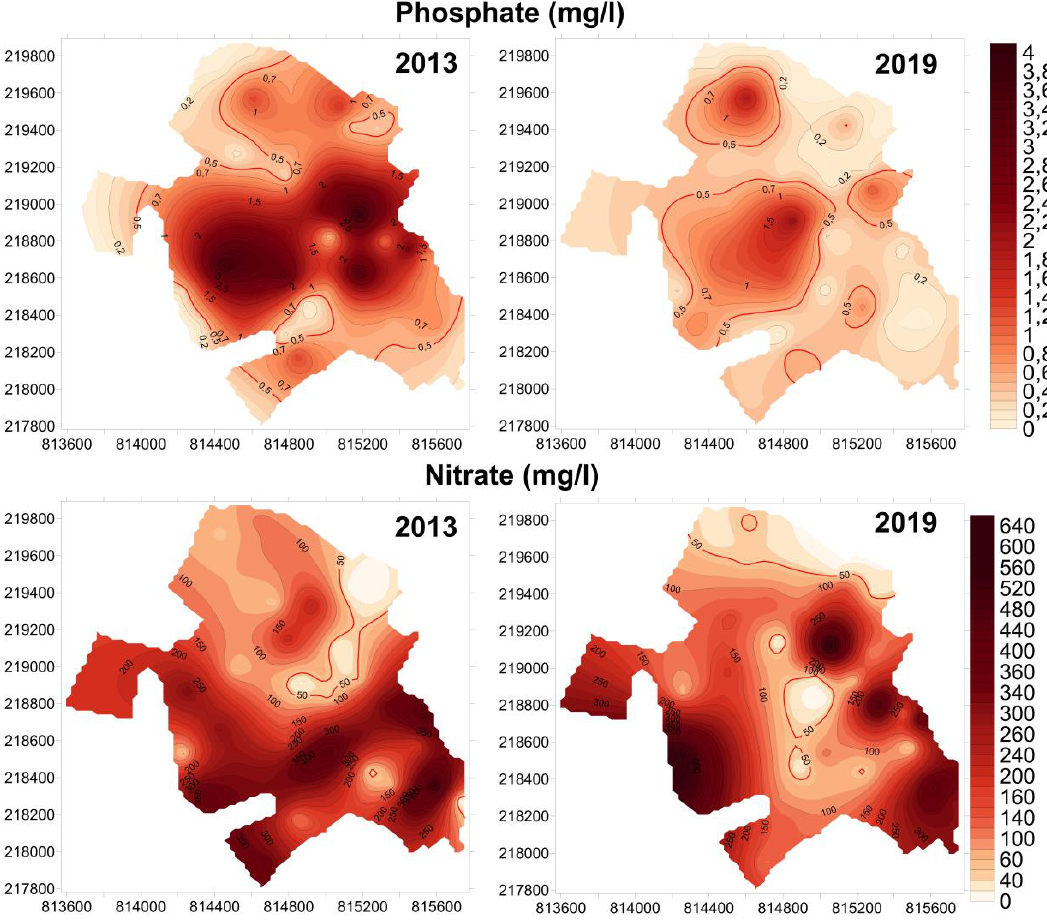
Figure 5. Distribution map of investigated